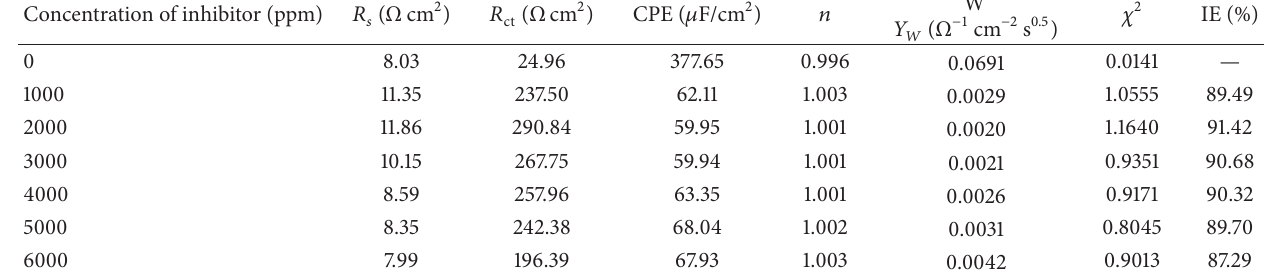
Table 5: Fitting results of EIS data for 304SS in 0.5 M H 2 SO 4 without and with inhibitor. Concentration of inhibitor (ppm)